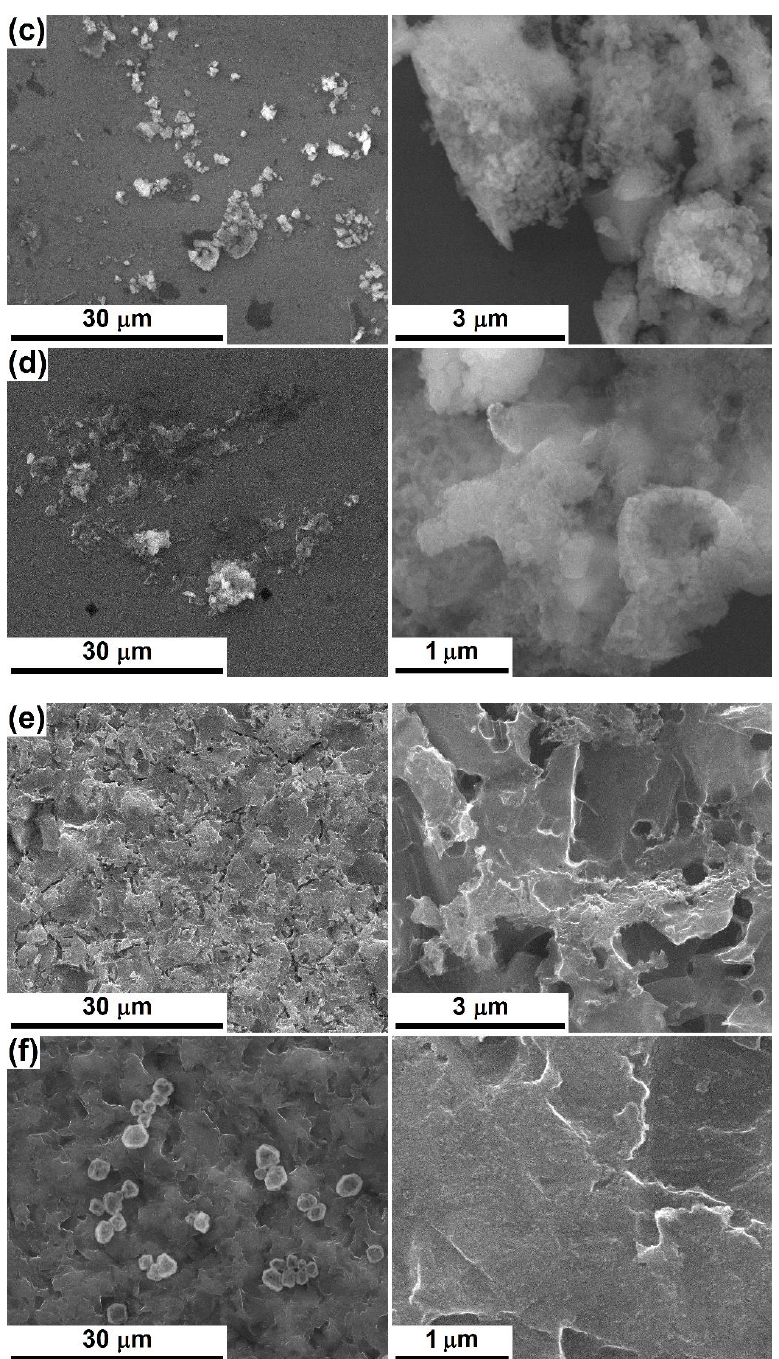
Figure 5. SEM images at different magnifications, after 28 days of immersion in SBF, of: ( a ) PLD-Mg-1, ( b ) PLD-Mg-2, ( c ) PLD-Sr-1, ( d ) PLD-Sr-2, ( e ) SC-Mg and ( f ) SC-Sr interfaces. Cellular viability and proliferation testing was performed through the LIVE/DEAD assay and fluorescence microscopy after 1 or 4 days of culturing the human fetal osteoblasts in the presence of the developed coatings. The corresponding images are comparatively displayed in Figure 6, where the viable cells are coloured in green and the nuclei of dead cells in red. Reported to the Control (represented here by a bare silicon plate), the deposited interfaces support cellular adhesion and